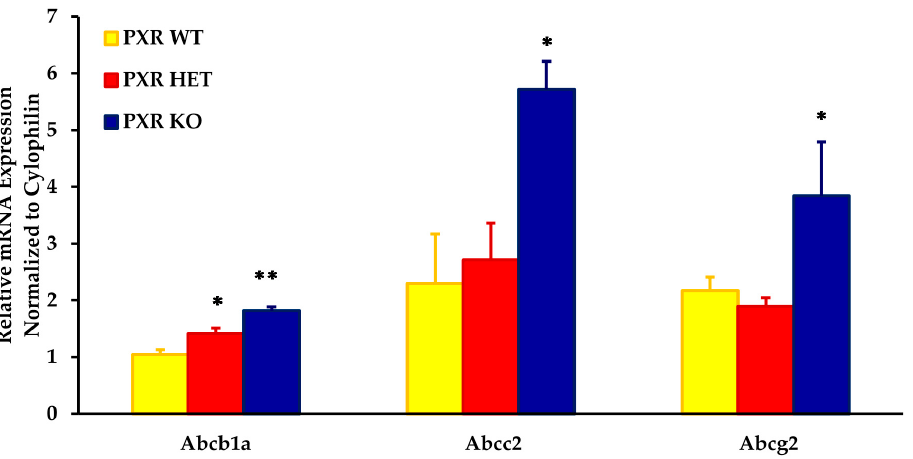
Figure 1. Effect of fetal genotype on basal mRNA expression of key placental transporters on GD 17. Fetal genotypes are PXR +/+ (PXR WT), PXR +/ − (PXR HET), and PXR − / − (PXR KO). Placental mRNA expression was measured using RT-PCR and normalized to cyclophilin. Values are